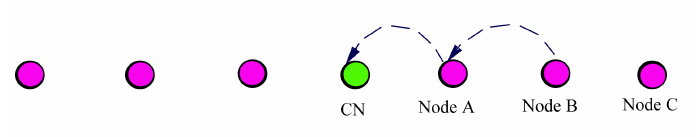
Figure 4. Example showing the usage of wait